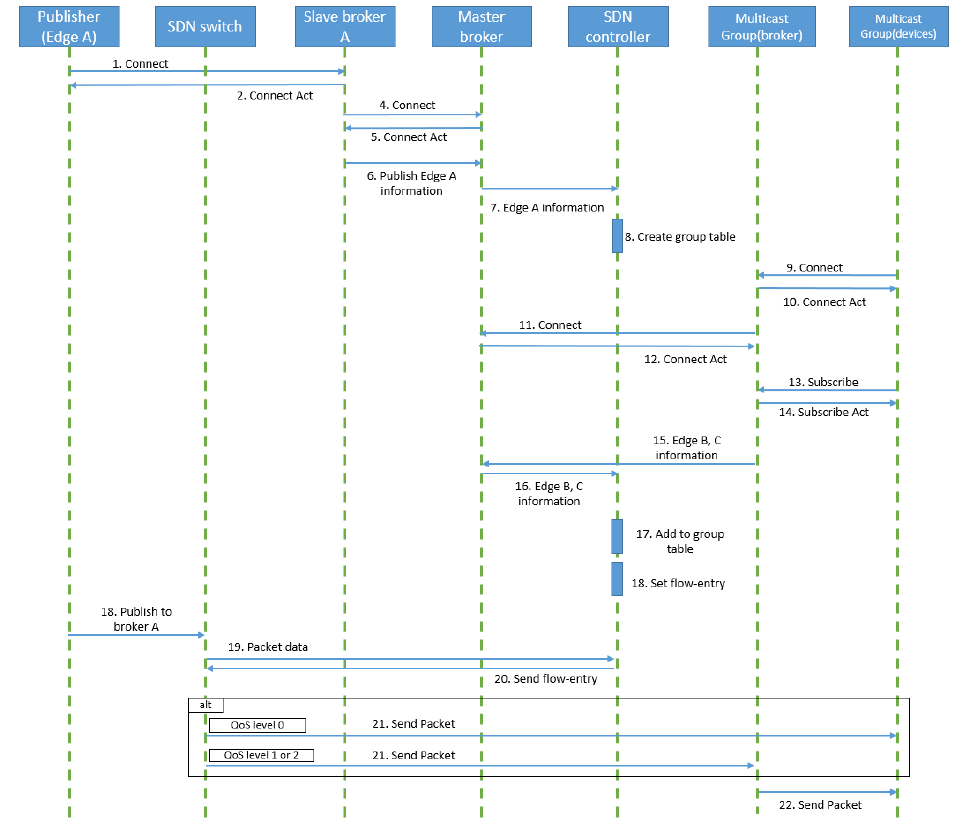
Figure 2. Data transfer sequence diagram of DM-MQTT.